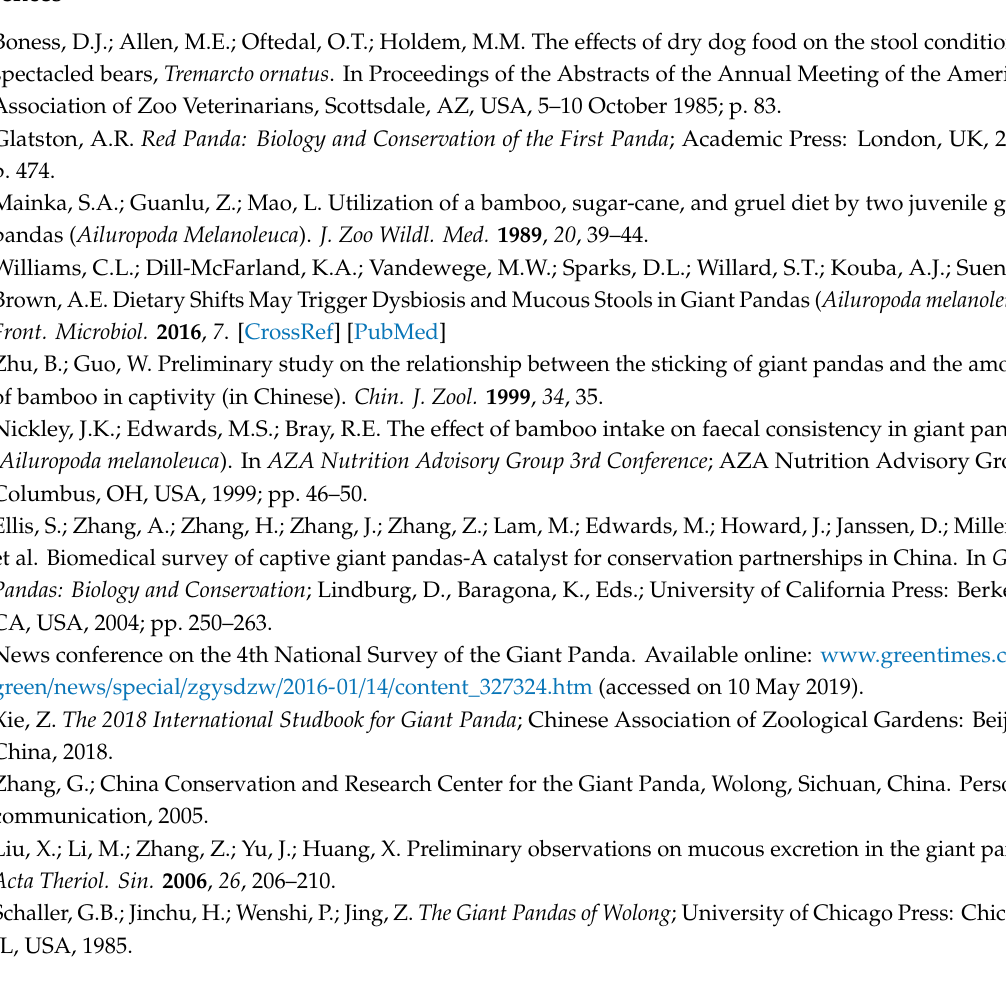
Figure S1: The contour maps of feces output (kg) and frequency of mucous stools (times) for each panda at Beijing Zoo from 2003 to 2017. The upper panel in each figure indicates the mucoid occurrence and the lower panel indicates the feces output for each panda. (a). Benben; (b). Jinghui; (c). Dabaitu; (d). Xiaobaitu; (e). Fulu;